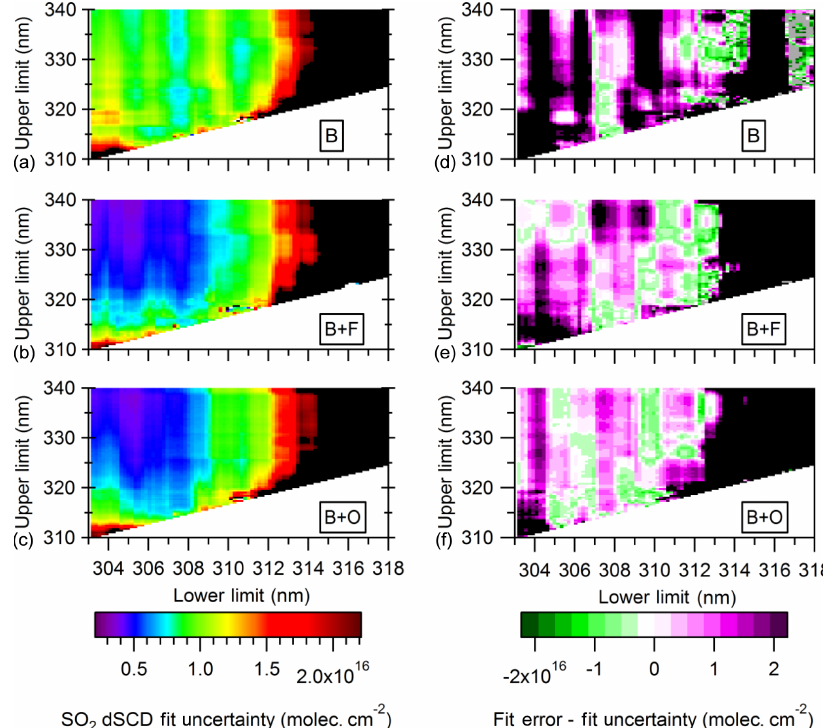
Figure 9. Higher concentration SO 2 dSCDs’ fit uncertainties (a, b, c) and the difference between the fit error and uncertainty (d, e, f) from spectra measured at a 2 ◦ elevation angle for the base case, B; with the offset, B + O; and with the filter, B + F. Black areas indicate errors >1 . 1 × 10 16 molec.cm − 2 for the absolute error (a, b, c) and >2 . 2 × 10 16 molec.cm − 2 for the difference (underestimation) between the actual and fit